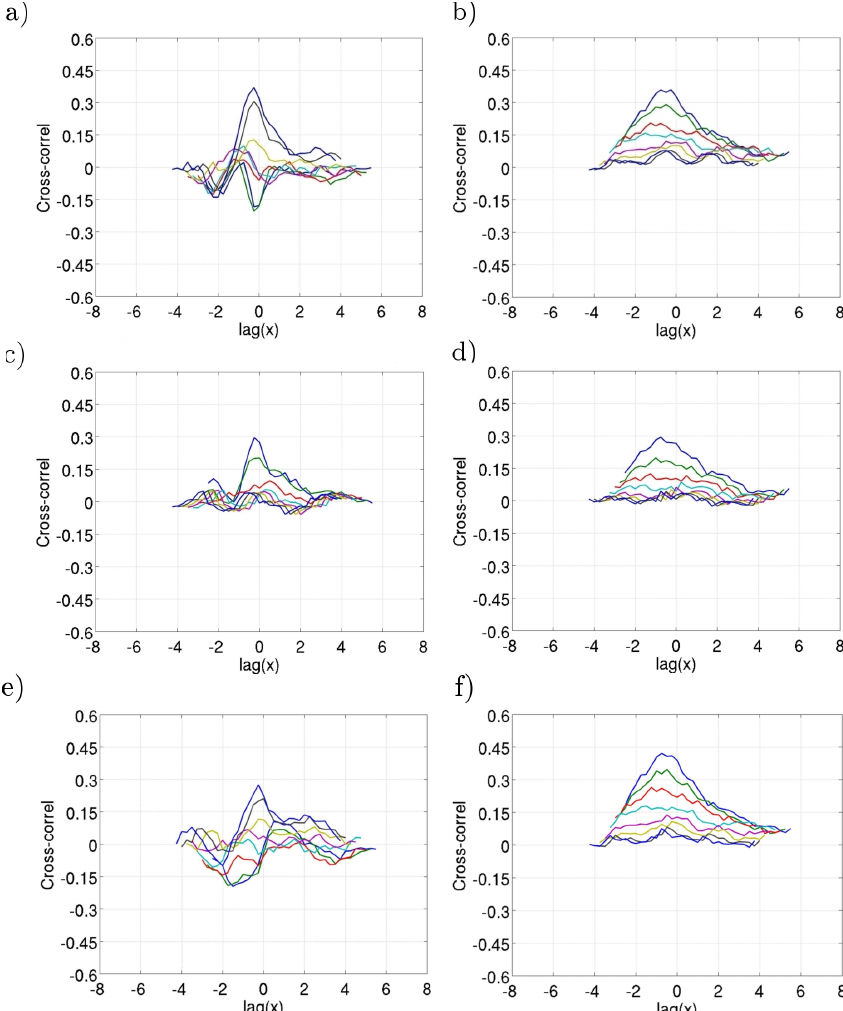
Fig. 7. Y − C cross correlation at t =2 T for the nodes located at y =5.75 L in scenario 1a (a) , scenario 1b (b) , scenario 3a (c) , scenario 3b (d) , scenario 4a (e) , and scenario 4b (f) . Each color corresponds to a correlation structure centered at a different node sampled by the plume (see Fig. 2a) .